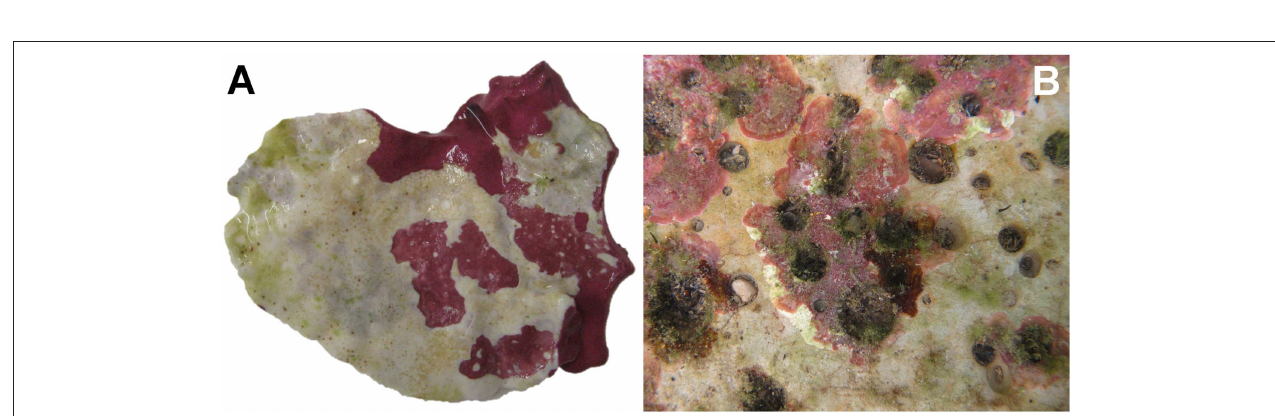
FIGURE 2 | Examples of necroses in Mediterranean corallines. (A) Lithophyllum cabiochae , close-up view of a specimen largely bleached. (B) Encrusting corallines showing incipient bleaching at the edges (Piscinetta del Passetto, Ancona, Italy).